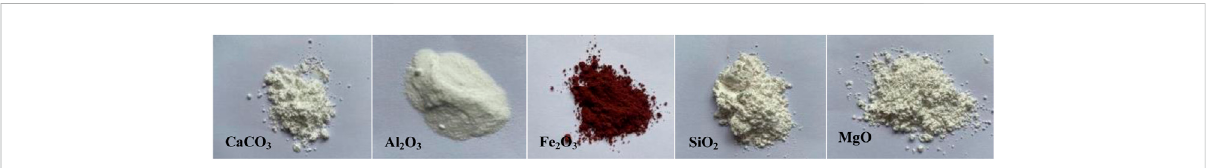
FIGURE 3 The fi ve materials selected to represent the main chemical components of aggregate.